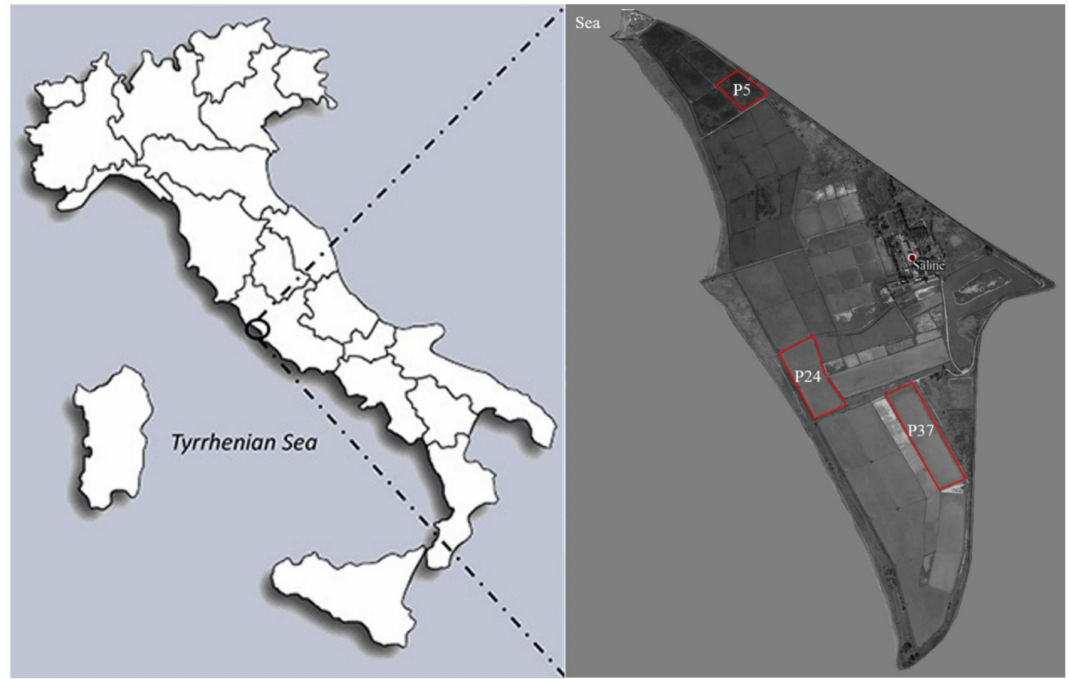
Figure 8. Detailed map of the “Saline di Tarquinia” (Viterbo, Italy) marine salterns with indication of the sampling sites (Sea, P5, P24 and P37). Map was generated using Google Earth Pro version 7.3.1 and graphically